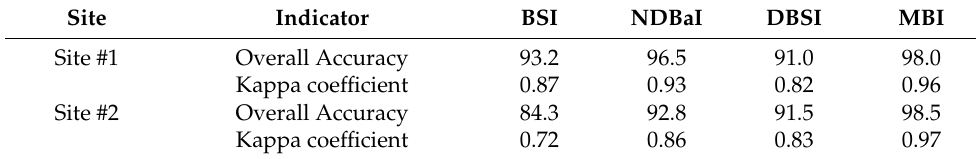
Table 2. Accuracy assessment of bare soil features extracted by four bareness indices.